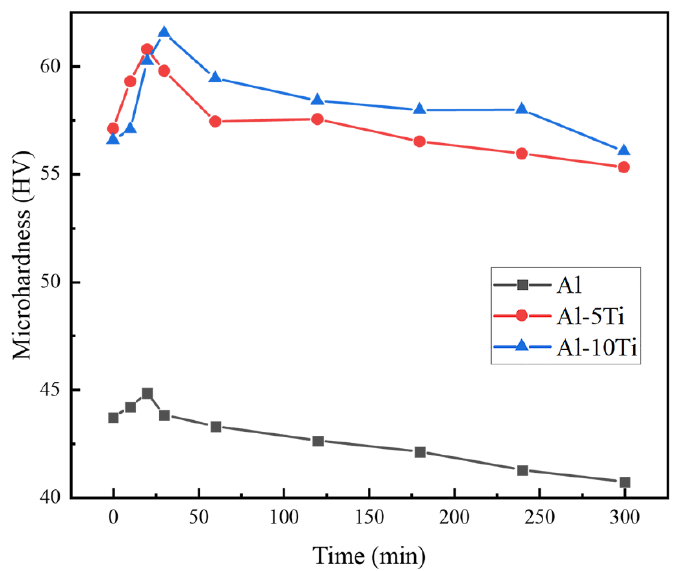
Figure 10. The microhardness of samples after different cavitation erosion time in 3.5 wt.% NaCl solution.